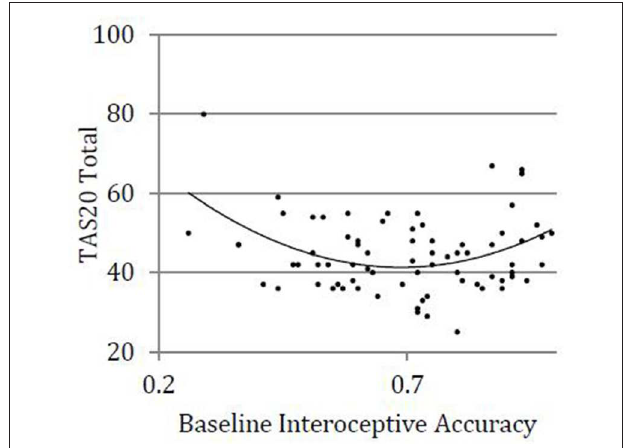
FIGURE 1 | Quadratic relationship between alexithymia and interoceptive accuracy.